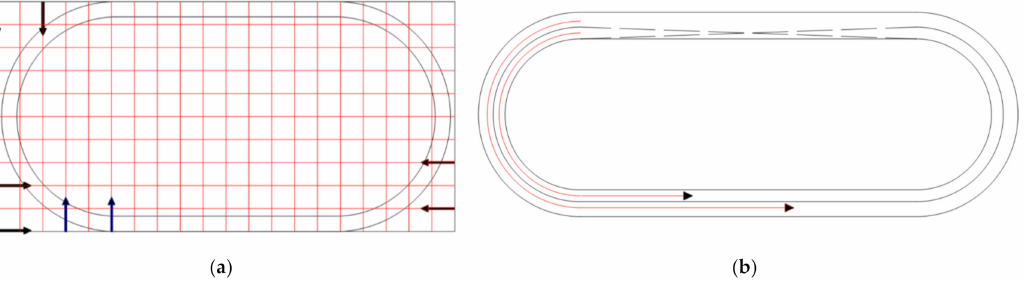
Figure 10. Measurement routes for different floors. ( a ) inspection route for wide rectangle floor block. ( b ) inspection route for runway